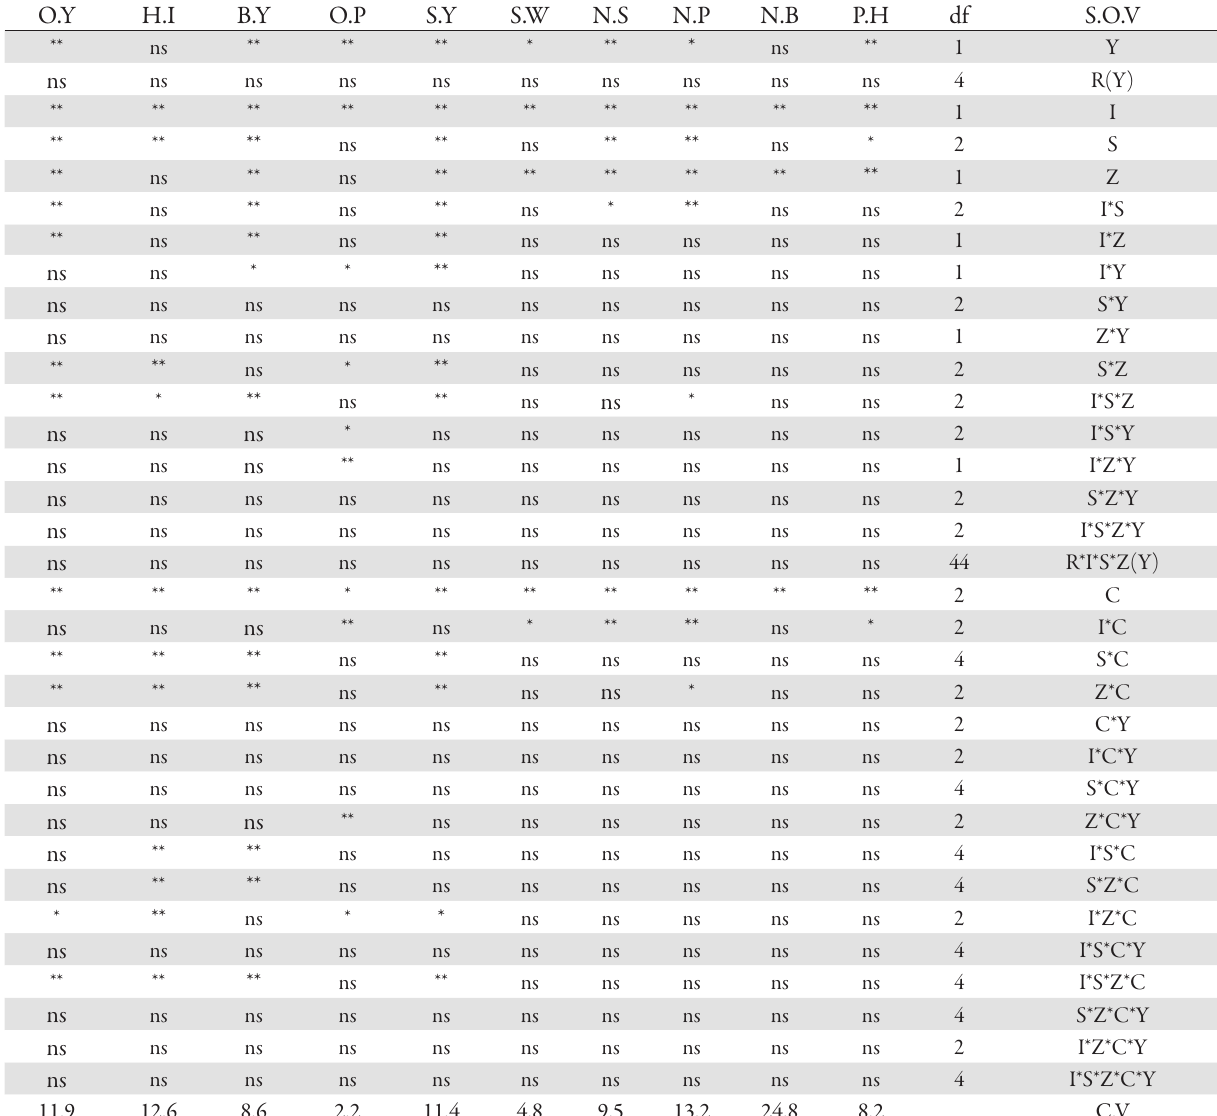
Tab. 2. Summary of combined F significance from analysis of variance of irrigation, zeolite, selenium and cultivar in 2006 and 2007